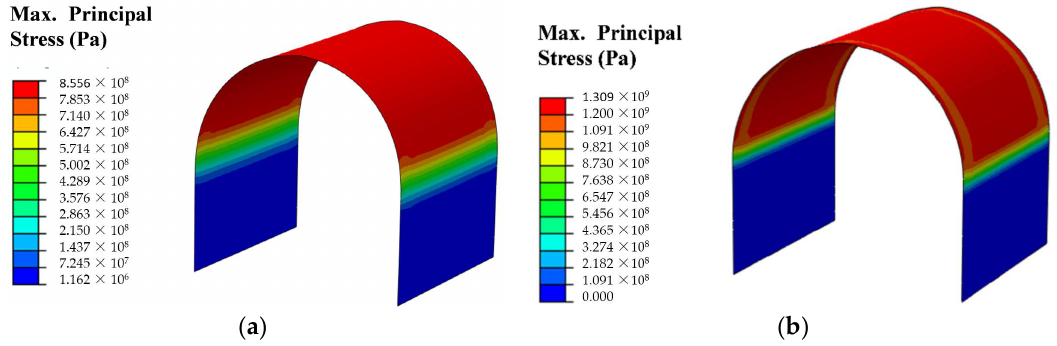
Figure 14. Distributions of maximum principal stress in ITO thin film on ( a ) PET substrate and ( b ) PEN substrate.